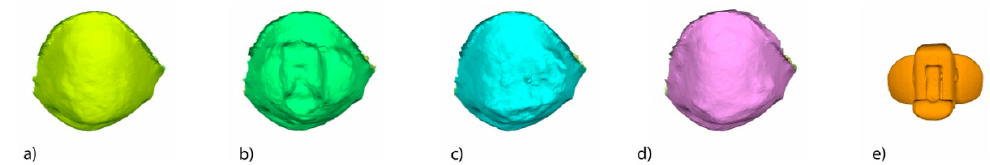
Figure 3. Palatal view of STL1 ( a ), STL2 ( b ), STL3 ( c ), and STL4 ( d ) digital files from segmented